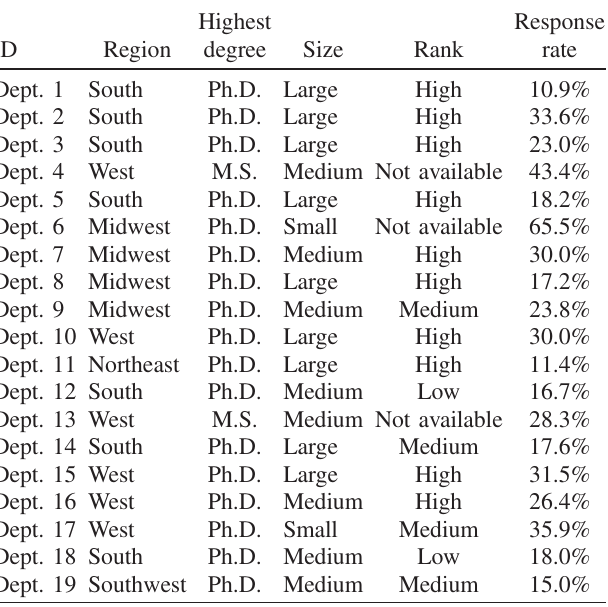
TABLE I. Characteristics of each of the 19 physics graduate programs. Note that the average response rate is 23.4%. The response rate is the ratio of the number of students that completed more than 90% of the survey items to the total number of students enrolled in the program. We purposefully do not disclose the exact number of students enrolled at each program to avoid program identification. The size refers to the total number of students enrolled at the program, where (a) ≤ 50 , small; (b) 51 – 100, medium; (c) ≥ 101 , large. Similarly, the program ’ s ranking is presented in the following categories: (a) 1 – 50, high; b) 51 – 100, medium; c) ≥ 101 , low. Information on the size of each